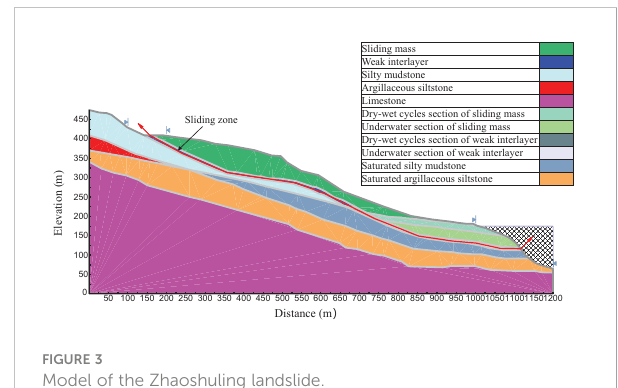
FIGURE 3 Model of the Zhaoshuling